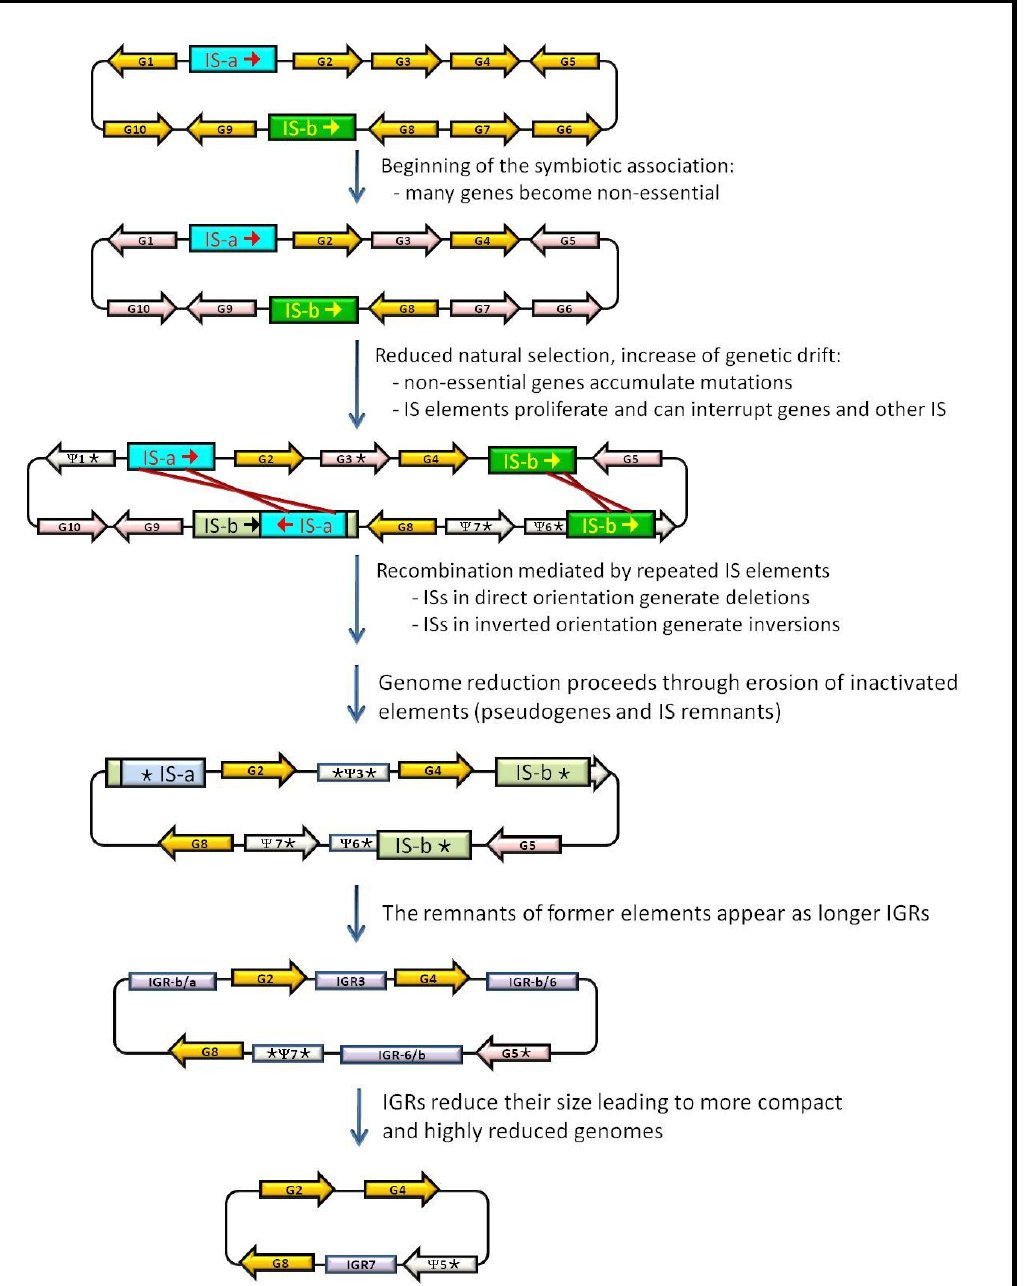
Figure 1. Dynamics of gain and loss of junk DNA in bacteria that establishes a host- dependent lifestyle. Details are given in the text. Orange arrows: essential genes; pink arrows: non-essential genes; white arrows: pseudogenes; blue and green boxes ISs that are active (dark colour) or inactive (light colour); light purple boxes: